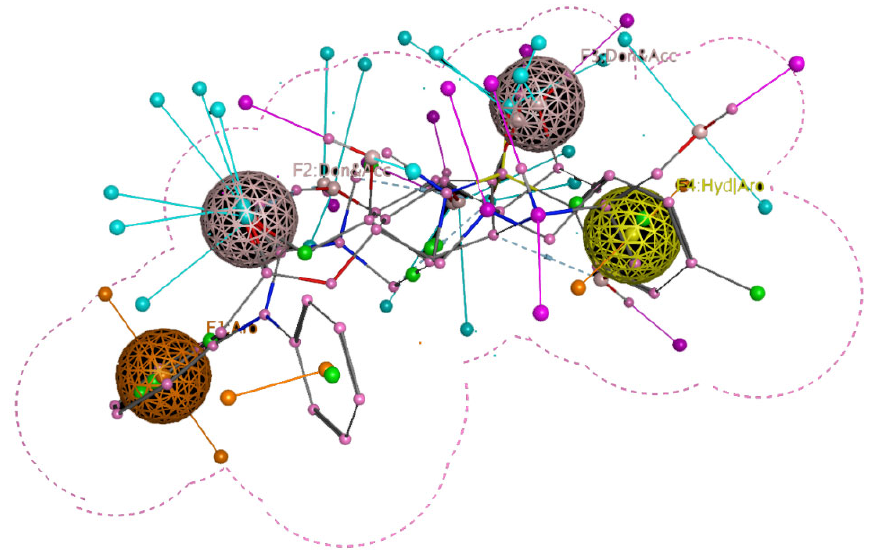
Figure 6. Pharmacophore query for screening purposes. Color balls represent HBA, HBD, hydro- phobic, and aromatic groups.